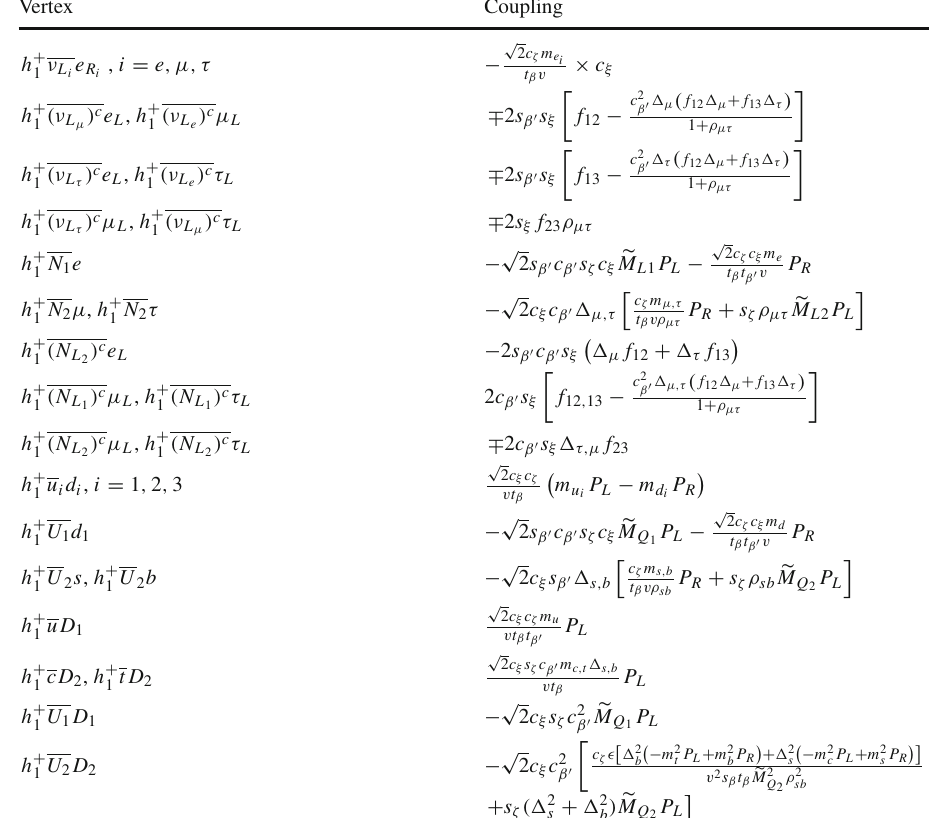
Table 4 Couplings of charged Higgs boson h + . Couplings of 1 h ± are only different from those 2 of h ± by replacements: 1 → s ξ h ± c ξ h ± and 1 2